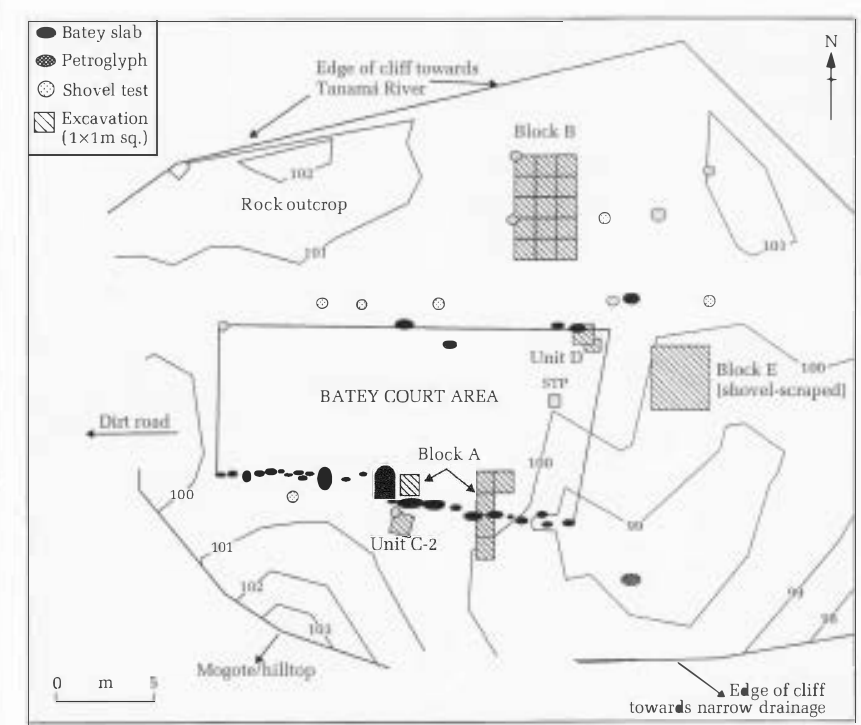
Figure 3 Utuado-Caguana Project, Puerto Rico. Topographic map of the local civic­ ceremonial site U-53, showing the typical rectangular precinct with stone alignments. No domestic mid dens or habitation structures were detected, suggesting that it was a vacant locus that served as a public meeting place for the dispersed small habitation sites in the immediate area. The probable function of the precinct was as a place for conduct of the batey or Antillean rubber ball game (similar to those of Mesoamerica). The prehistoric component is estimated to date c. AD 1200-1500. (Contours at 1 m intervals.)